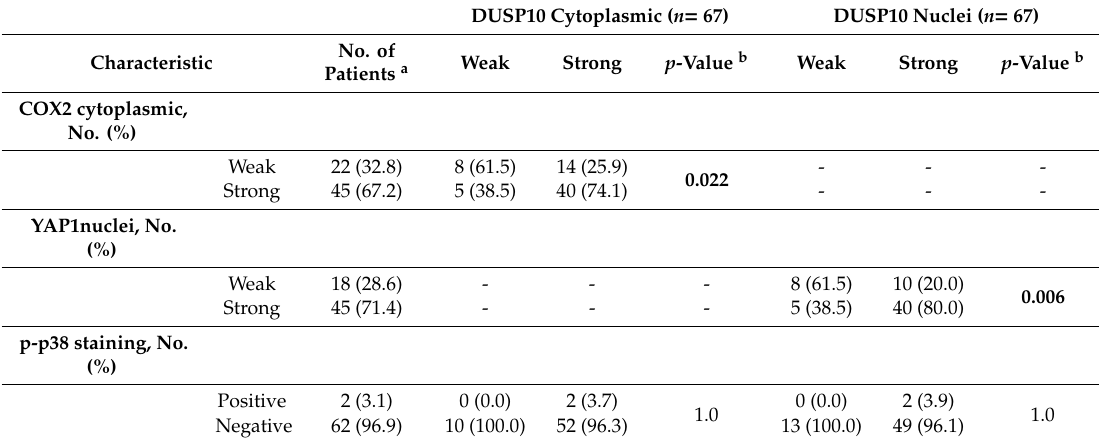
Table 1. Analysis of tumor epithelial tissue from colon cancer patients according to protein expression. COX2, DUSP10, YAP1, and p-p38 expression are analyzed in tumor epithelial tissue from a cohort of 73 colon cancer patients. Two-way ANOVA analysis was